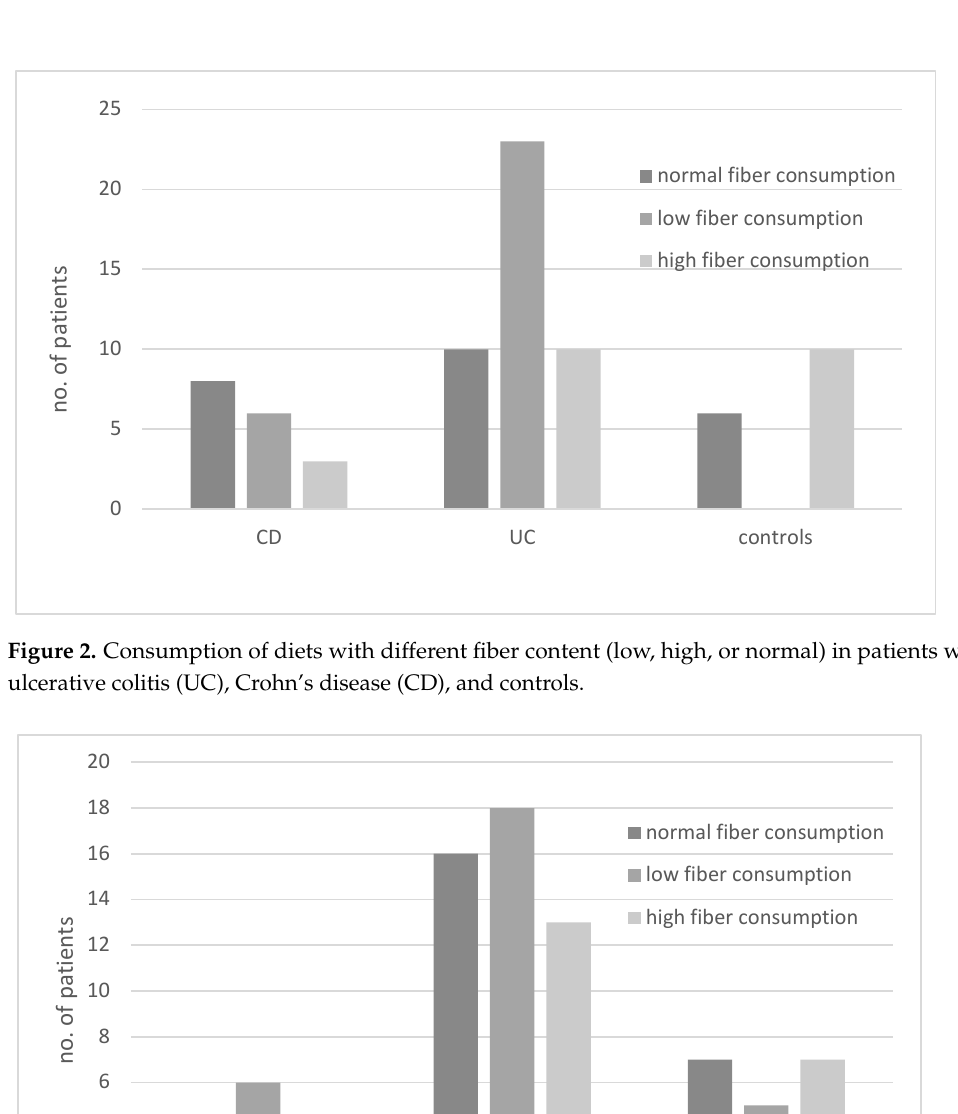
Figure 3. Comparison of dietary fiber intake in underweight (body mass index (BMI) < 18.5 kg/m 2 ), normal-weight (BMI 18.5–24.99 kg/m 2 ), and excessive-weight (BMI > 24.99 kg/m 2 ) subjects.